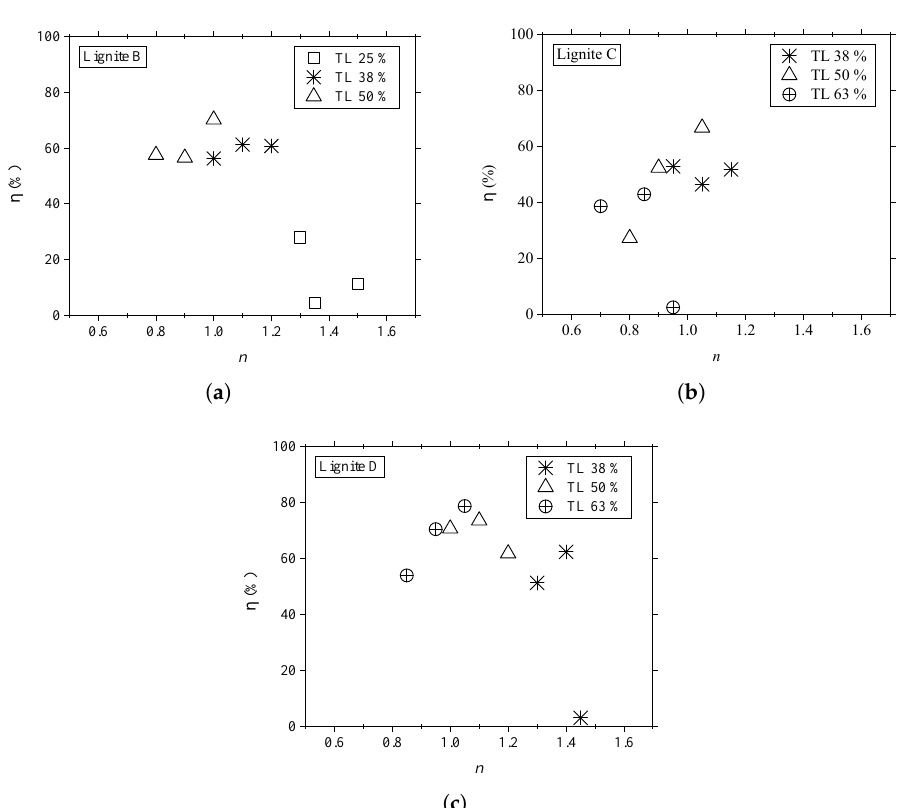
Figure 5. The Combustion Degree vs. air ratio at several thermal loads (TL) by ( a ) Lignite B, ( b ) Lignite C and ( c ) Lignite